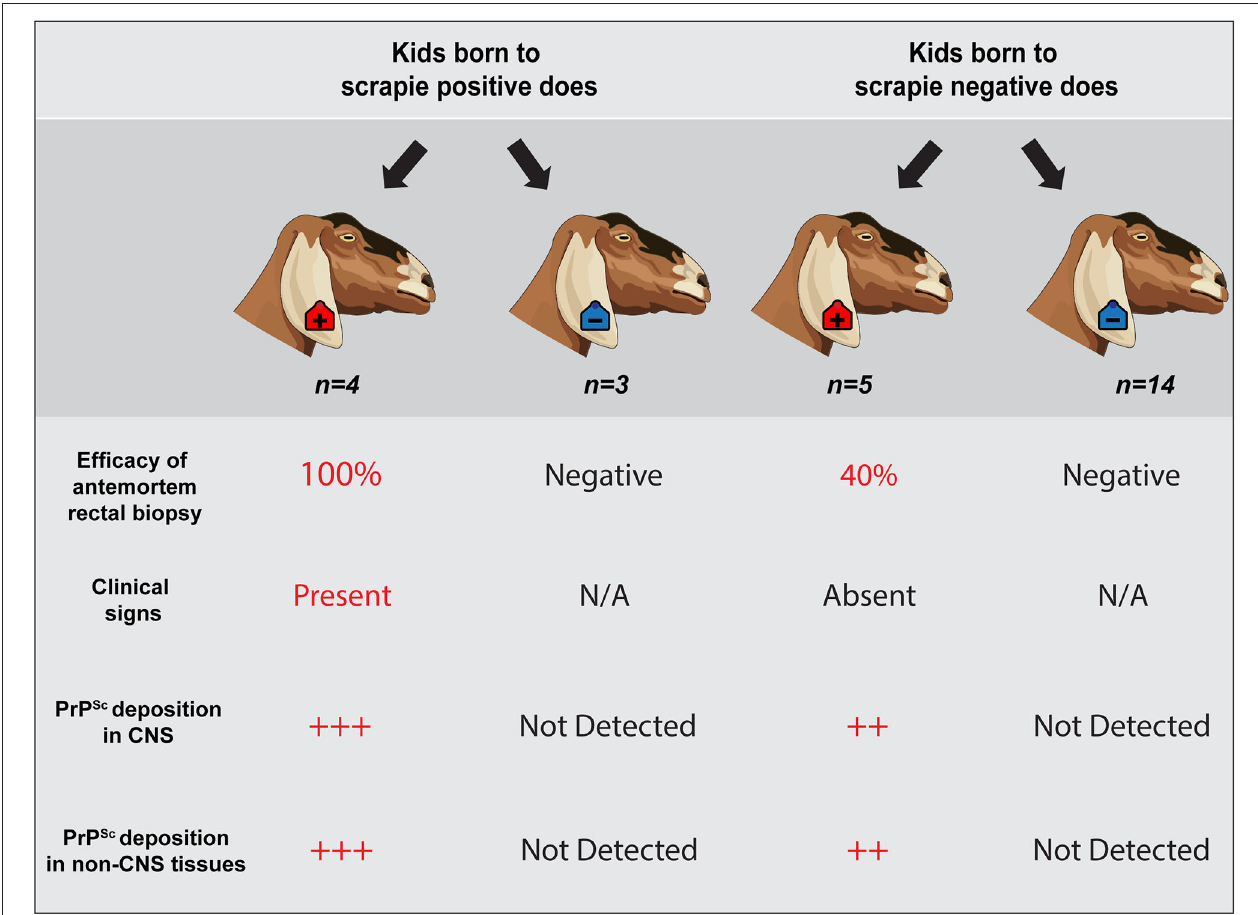
FIGURE 4 | Summary of results. Representative schematic illustrates a correlation between a positive antemortem rectal biopsy, presence of neurologic clinical signs, unequivocal PrP Sc accumulation in central nervous system and non-CNS tissues , and a positive dam status. However, scrapie status of the dam does not predict infection of the offspring. Animals observed in this study are highlighted within a dark gray shaded outline ( n = 26 offspring). Four scrapie-positive goats and 3 scrapie-negative goats were born to seven different scrapie-positive does; five scrapie-positive and 14 scrapie-negative goats were born to 19 different scrapie-negative does. Two goats that were born to does with an unknown dam status are not